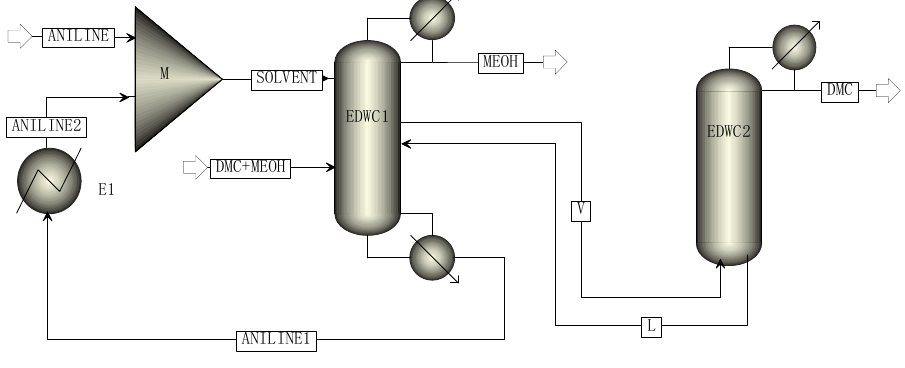
Figure 4. The simulation process of EDWC.